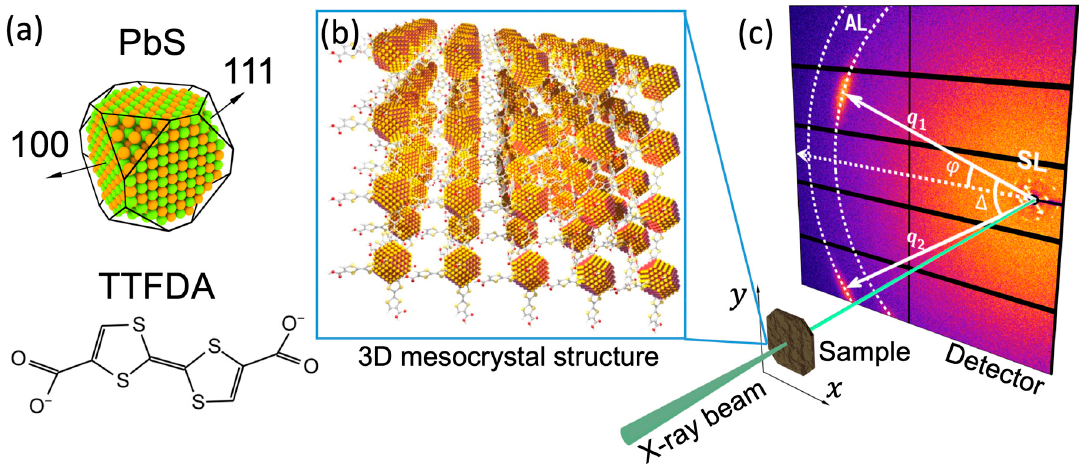
Figure 15. ( a ) Schematic view of a single PbS nanoparticle with the shape of a truncated cube with six 100 and eight 111 facets, and the chemical structure of the tetrathiafulvalenedicarboxylate (TTFDA) anion; ( b ) Structure of a mesocrystal formed by PbS nanoparticles crosslinked with TTFDA molecules; ( c ) Scheme of the diffraction experiment, in which small angle scattering from the mesocrystal superlattice and wide angle scattering from PbS atomic scattering were recorded simultaneously by a large 2D detector. (Adapted with permission from Zaluzhnyy et al. [18]. Copyright (2017) American Chemical Society).